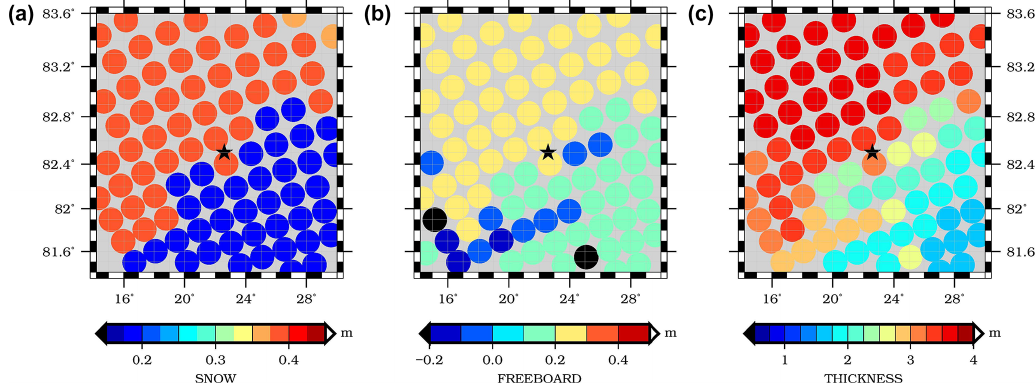
Figure 10. Results from CryoSat-2 sea ice products from GSFC averaged for the month of March 2015 for a region of 250km × 250km over the in situ site in the Norwegian Arctic for (a) snow depth, (b) sea ice freeboard and (c) sea ice thickness. The position of R/V Lance is marked with a